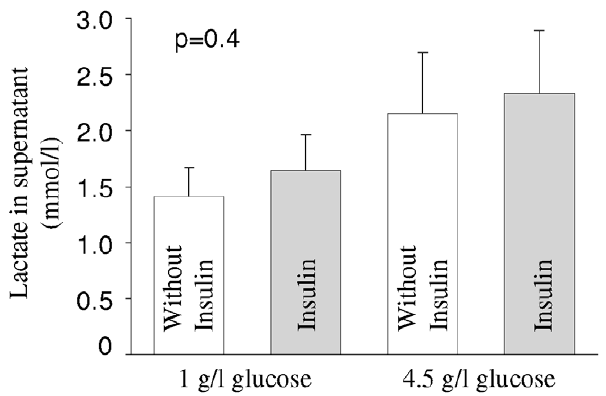
Figure 4. Effects of insulin stimulation and glucose concentra- tion on lactate secretion of human astrocytes. Prior to experiment, NHAs were either starved in medium containing 1 g/l glucose or kept in medium with 4.5 g/l. Medium was than replaced by new medium with the same glucose concentrations without (white bars) or with 50 nM insulin (grey bars). After 8 hours, lactate concentration in the supernatant was measured. Bars represent means of five independent experiments + SEM. There were no significant differences between groups (ANOVA, p=0.4).